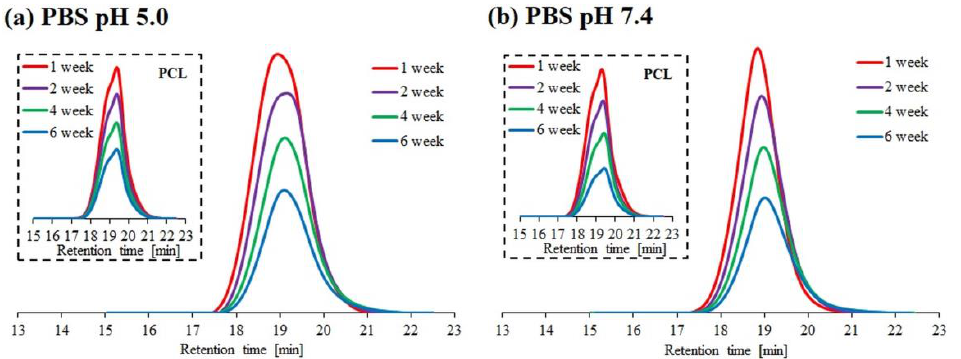
Figure 2. SEC traces obtained for hydrolytic degradation of copolymer 1PCL2- b- PDMAEMA at pH 5.0 ( a ) and pH 7.4 ( b ). SEC traces for the corresponding macroinitiator PCL2 are placed in brack- ets.